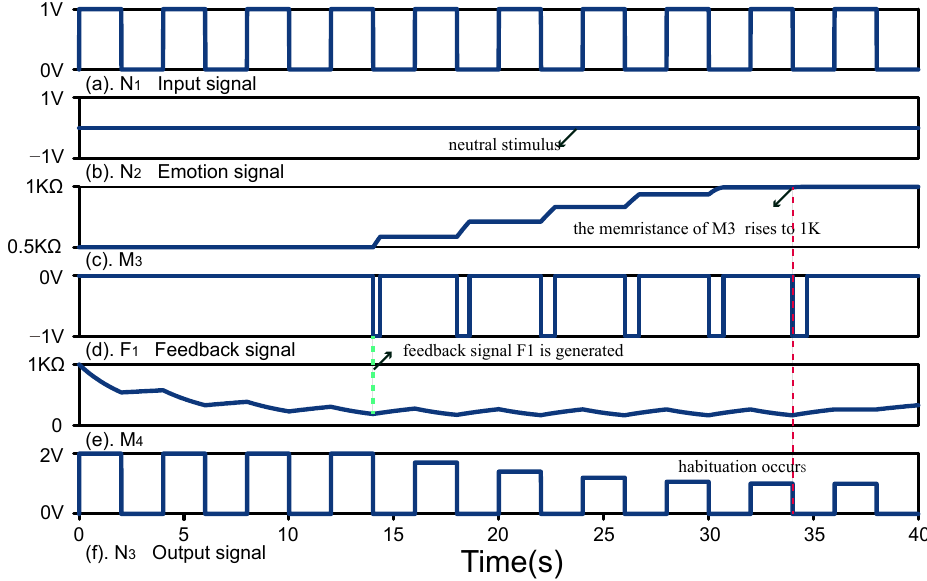
Figure 10. Habituation . ( a ) Input signal. ( b ) Emotion signal. ( c ) Memristance of M 3 . ( d ) Feedback signal F 1 . ( e ) Memristance of M 4 . ( f ) Output signal N 3